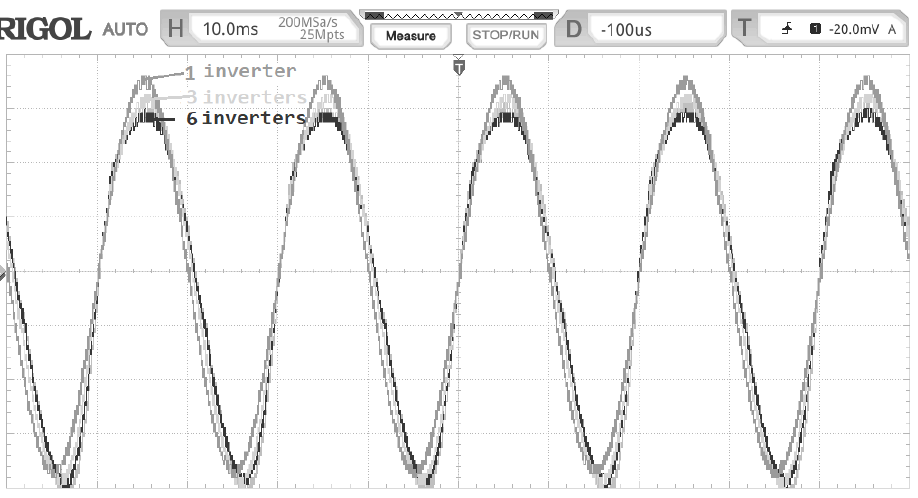
Figure 6. Comparison of the output voltage of 1, 3 and 6 inverters working in parallel. The guideline of allowable voltage levels and time of exceeding these levels are taken from IEEE standards [8]. These limits are presented in Figure 7. After connection or removal, the voltage should not exceed boundaries from 0.50 to 1.20 voltage (p.u.) in a period of maximum 0.16 s.